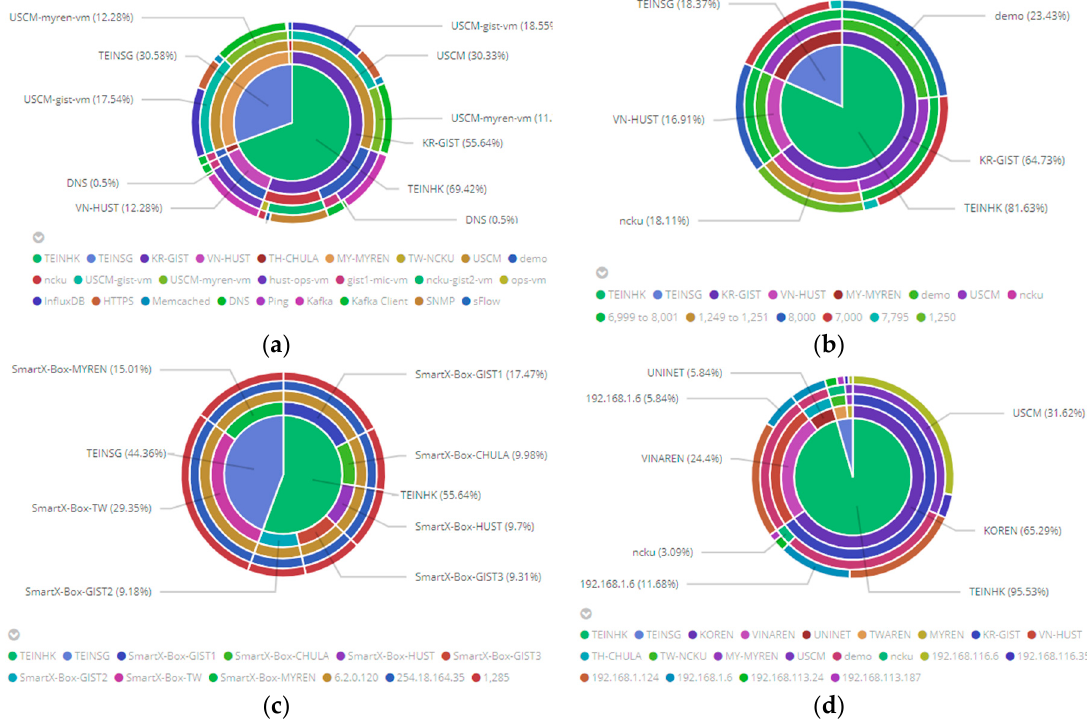
Figure 13. Network packets flow classification results. ( a ) Identified class, ( b ) known class, ( c ) unknown class and ( d ) attack class.